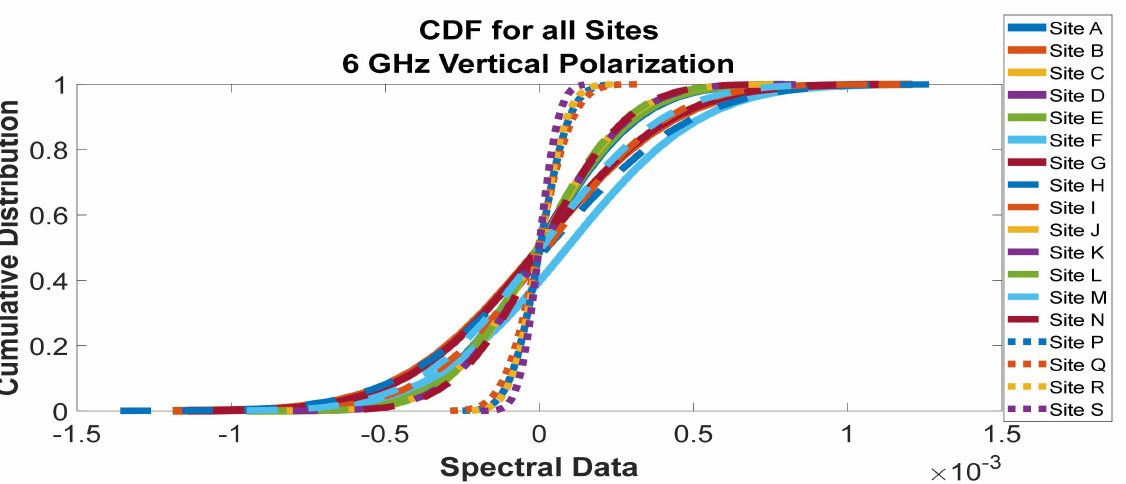
Figure 36. Cumulative distribution functions of frequency scan for all sites at 6 GHz vertical polarization.